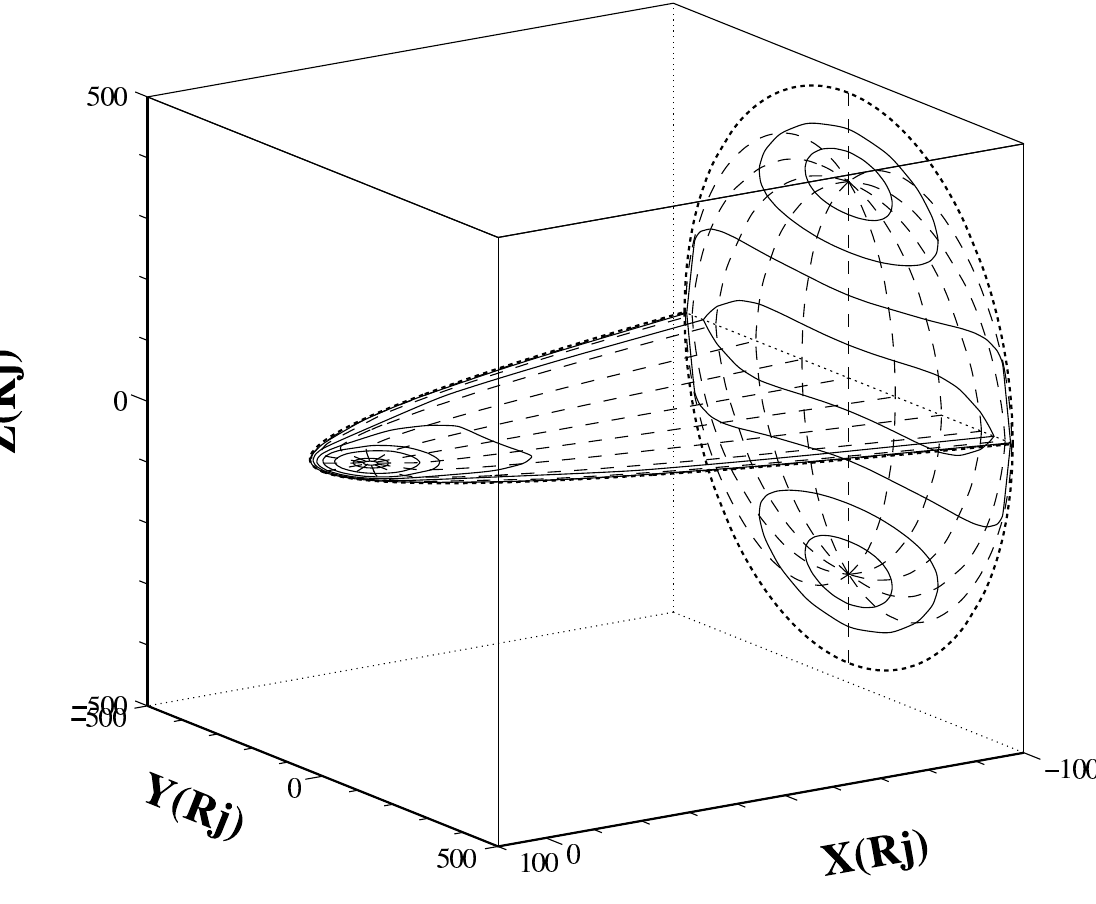
Fig. 8. Projections of the constant Jovian latitude with step 2 ◦ (solid curves) and constant longitude with a 2-h step (dashed curves) along magnetic field lines. Model parameters: 9 = 0; R ss = 100 R J ; R 2 = 65 R J ; B t =− 2 . 5nT; R D1 = 92 R J ; R D2 = 18 . 4 R J ; B DC = 2 . 5nT. The constant latitude curves in the equatorial plane are from 72 ◦ to 84 ◦ , and in the tail cross section from 82 ◦ to 90 ◦ .